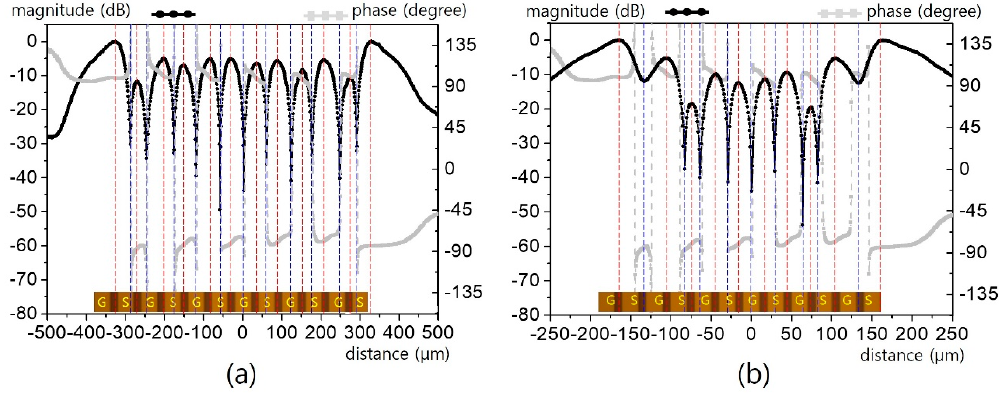
Figure 11. Horizontal electric field distribution for the interdigital lines in Figure 10: ( a ) for a 40 μ m line width, ( b ) for a 20 μ m line width.